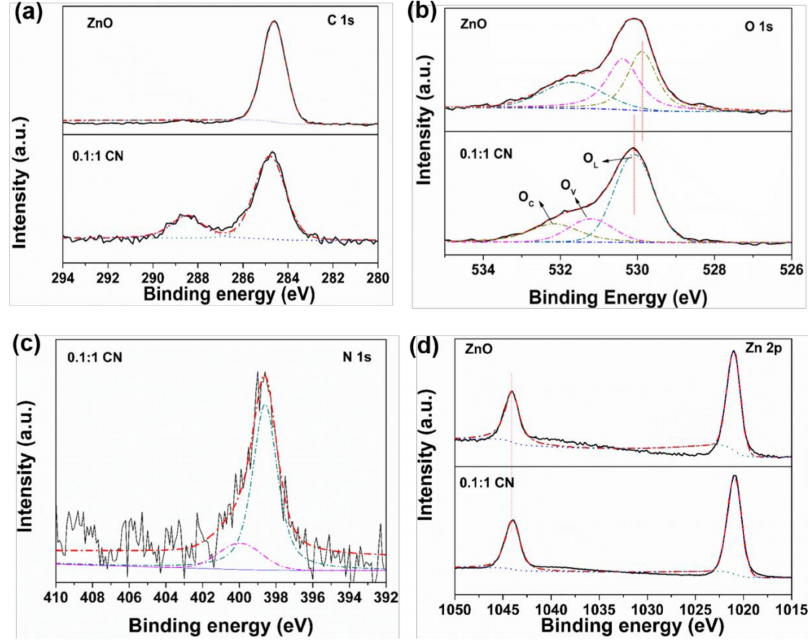
Figure 6. X-ray photoelectron spectroscopy (XPS) data for ( a ) C 1s, ( b ) O 1s, ( c ) N 1s, and ( d ) Zn 2p for the